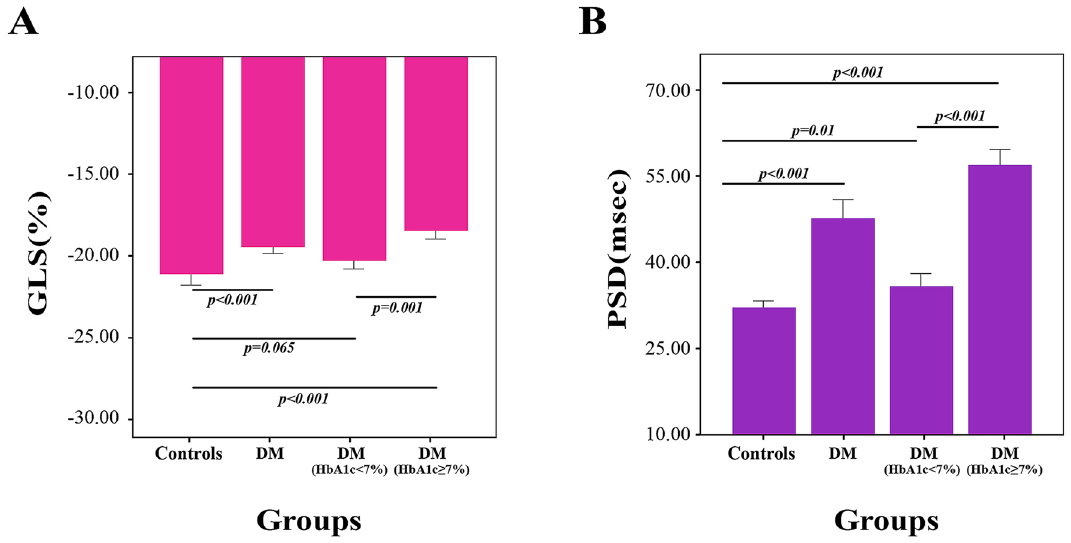
Figure 2. Impairment of GLS ( A ) and PSD ( B ) parameters in the LV in T2DM